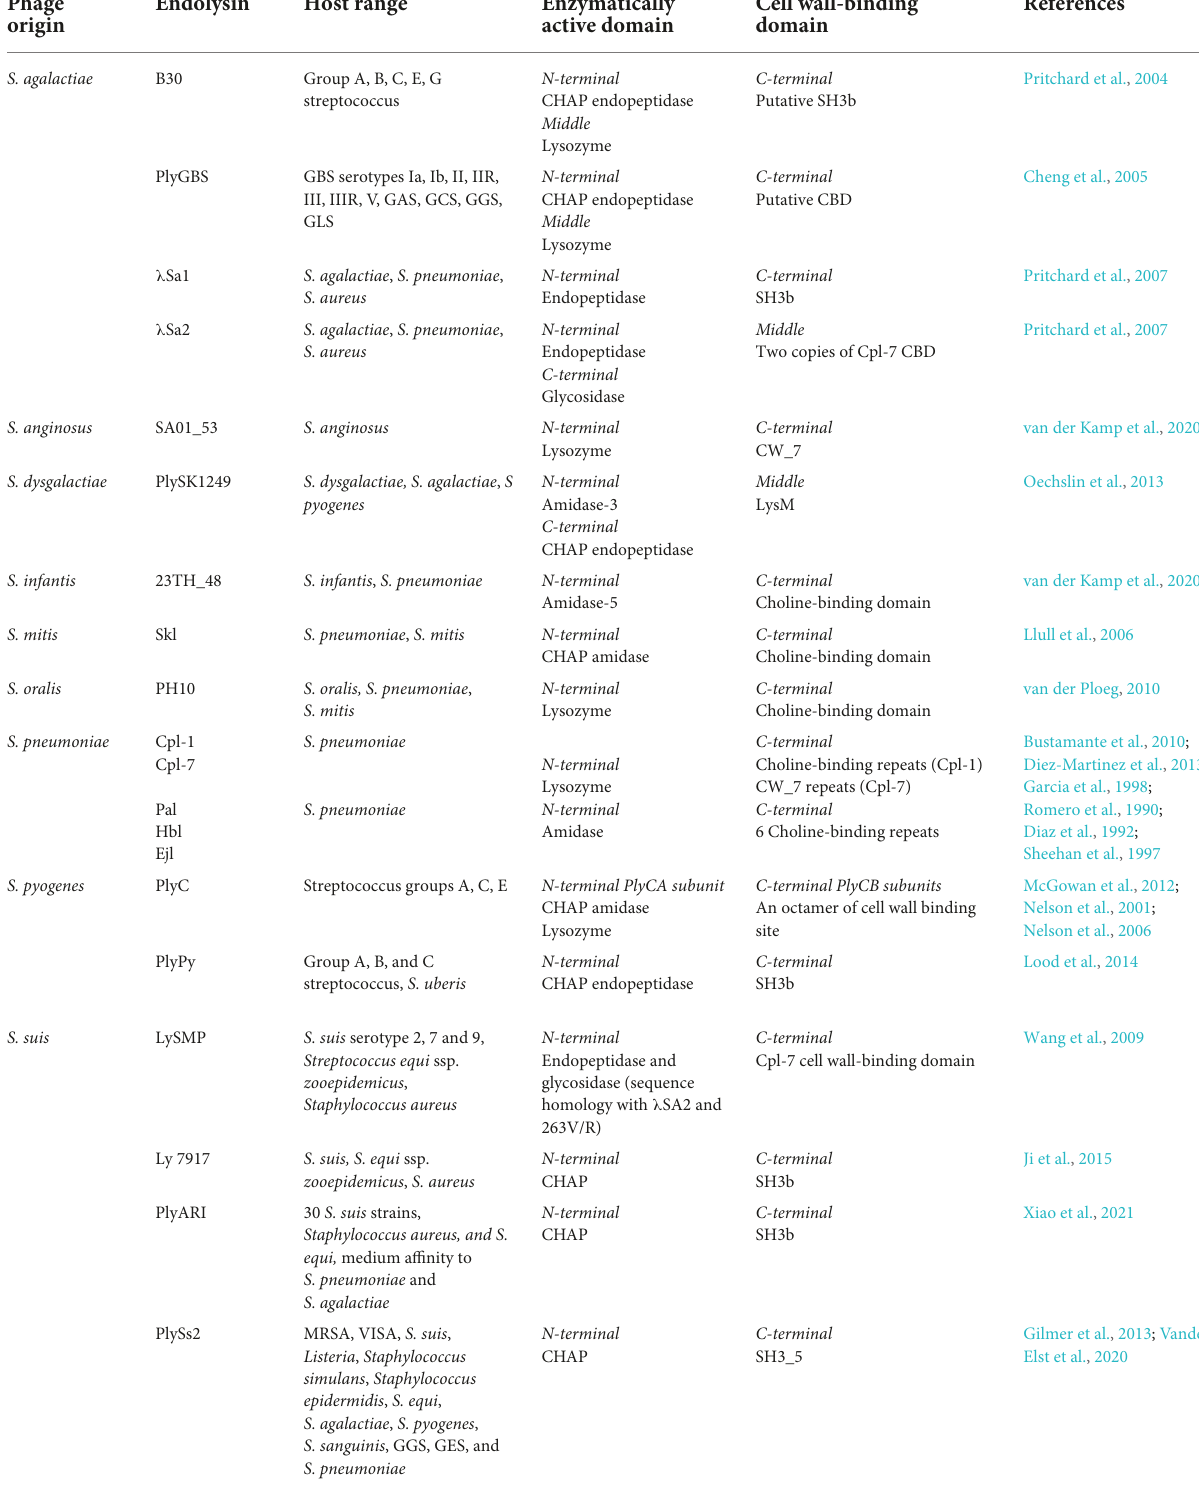
TABLE 1 Streptococcal phage lysin and their origin, host range, enzymatically active domains (EADs), and cell wall-binding domains (CBDs). Phage